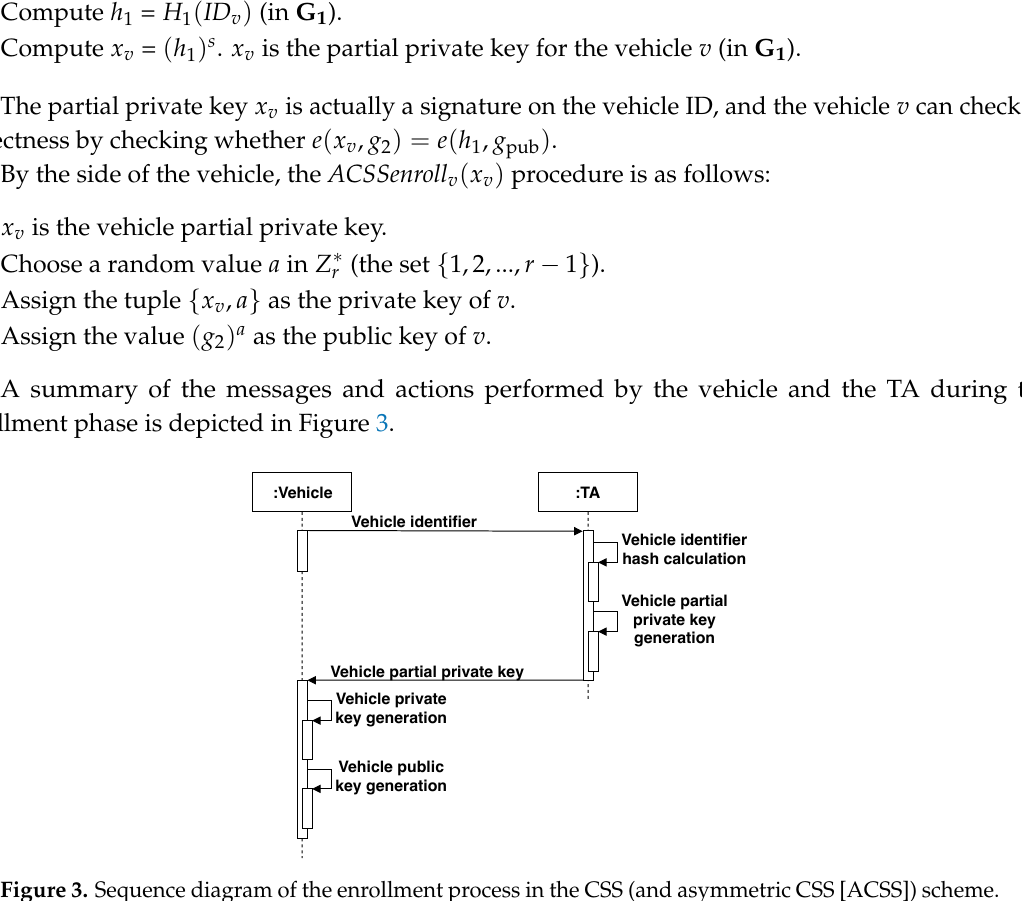
Figure 3. Sequence diagram of the enrollment process in the CSS (and asymmetric CSS [ACSS])